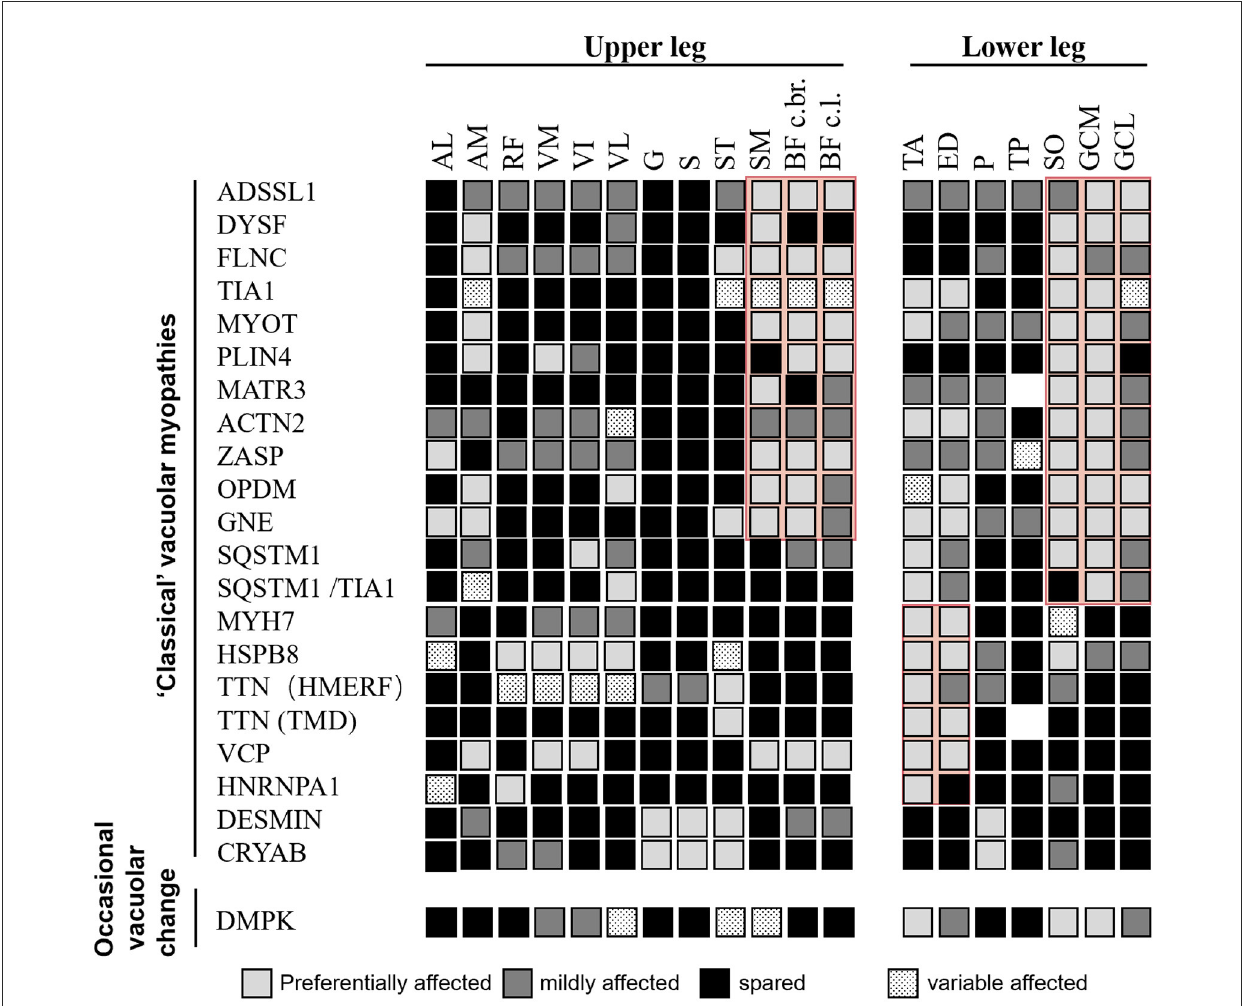
FIGURE3 Literature-based pattern of rimmed vacuolar myopathies with distal weakness. Both “classical” vacuolar myopathies (consistent vacuolar phenotype) and myopathies with occasional vacuolar changes are included. Disease entities showing relevant similarities are highlighted in red. Modified from Mensch et al.